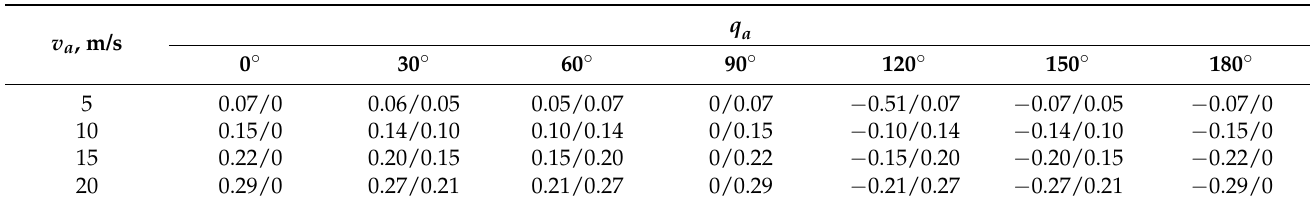
Table 3. The PANAMAX container vessel drifts speed depending on wind velocity and course angle ( v dX / v dY ) during crossing the navigational channel near Korsakobben Island (departure from Stockholm archipelago).